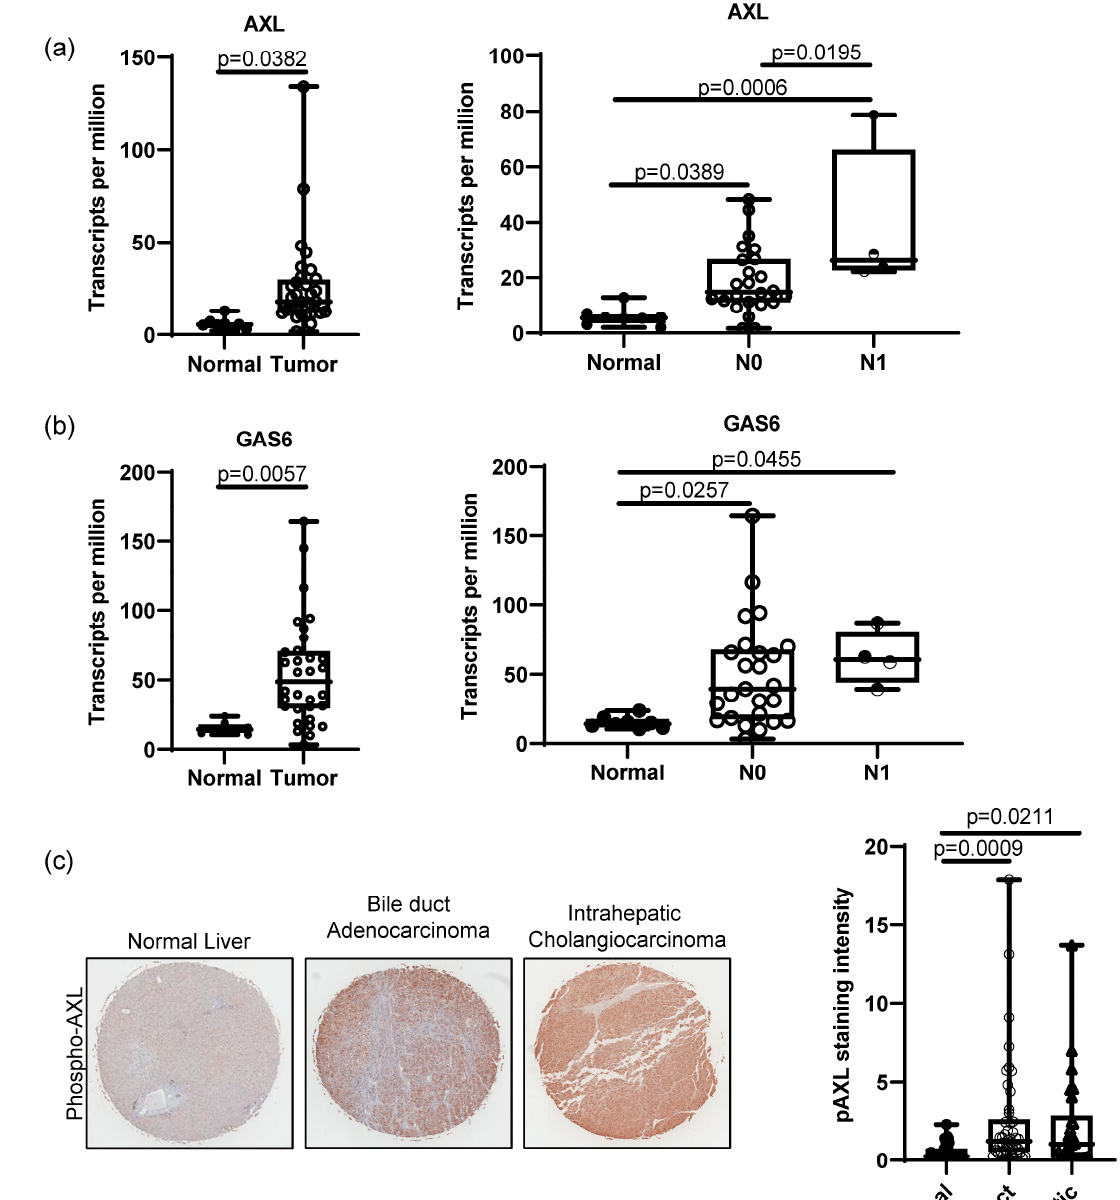
Figure 1. AXL expression in bile duct cancer patients. RNA sequencing data from TCGA analyzed by UALCAN showed that bile duct cancer tissues from patients highly expressed AXL ( a ) and GAS6 ( b ) compared to normal tissues (normal n = 8, bile duct cancer n = 32, p = 0.0382 for AXL and p = 0.0057 for GAS6, student’s t -test). UALCAN data present higher AXL expression in N1-stage (metastasis in 1–3 axillary lymph nodes) patients compared to normal and N0 (no metastasis) patients (normal n = 8, N0 n = 28, N1 n = 4; normal vs. N0 p = 0.0389, normal vs. N1 p = 0.0006, N0 vs. N1 p = 0.0195, one-way ANOVA with multiple comparisons). ( c ) Immunohistochemistry on TMA of cholangiocarcinoma (5 × magni fi cation) patients exhibited signi fi cantly high phospho-AXL expression in cancer tissues compared to normal liver tissues. Staining intensity was analyzed using ImageJ (normal n = 45, bile duct cholangiocarcinoma n = 26, intrahepatic cholangiocarcinoma n = 46, normal vs. bile duct cholangiocarcinoma, p = 0.0009, normal vs. intrahepatic cholangiocarcinoma, p = 0.0211, one-way ANOVA with multiple comparisons).